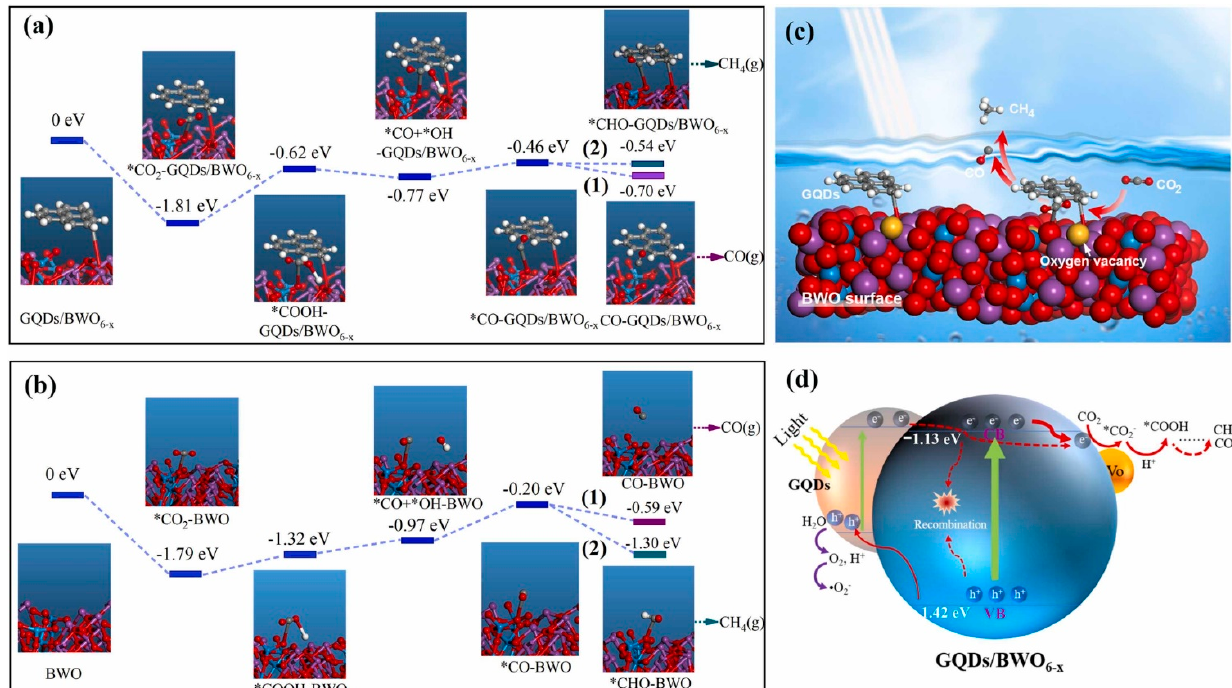
Figure 9. The free energy diagram for reducing CO 2 to *CHO or CO by ( a ) GQDs/BWO 6-x and ( b ) BWO. ( c ) Possible microstructure of GQDs/BWO 6-x . ( d ) Proposed photocatalytic CO 2 reduction mechanism by GQDs/BWO 6-x (reprinted with permission from [141], 2022, Elsevier).